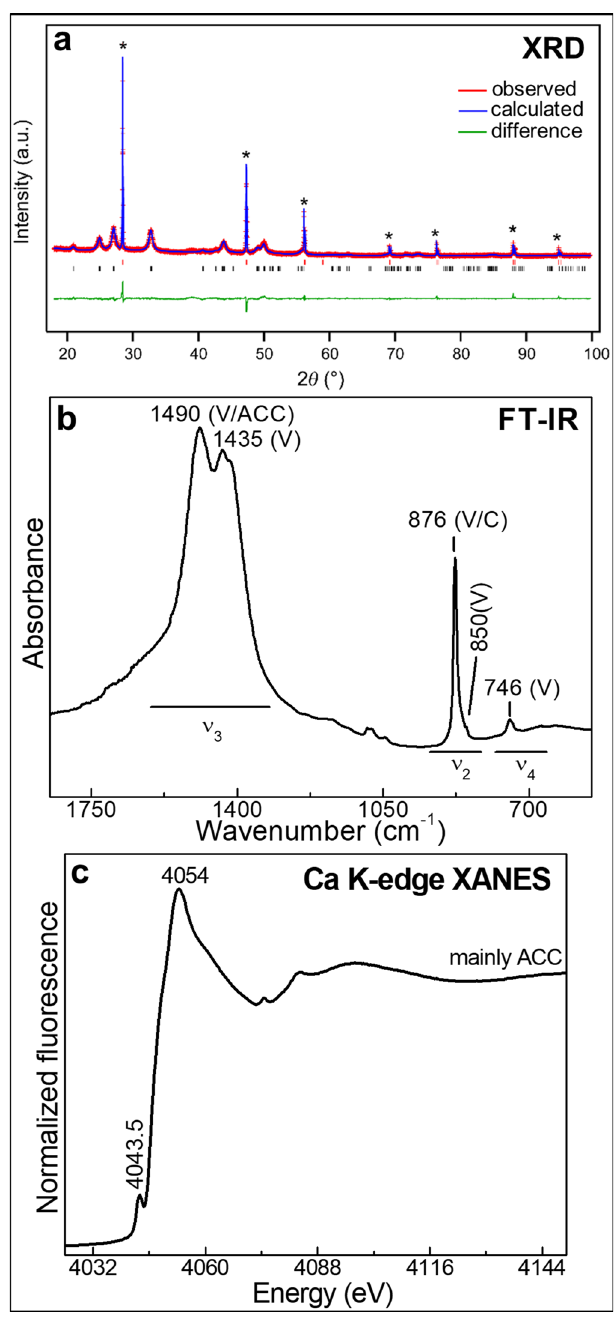
Figure 1. Bulk analysis of CFW consolidant after storing at RH = 50% (T = 40 °C, 5 months): (a) Rietveld refinement performed by GSAS 33 , (b) FT-IR and (c) Ca K-edge macro-XANES spectrum (unfocused beam, 200 µm pinhole) normalized by ATHENA 44 . In (a) , the peaks marked with an asterisk are related to the silicon added as internal standard. Red and black vertical bars at the bottom indicate the calculated positions of peaks for silicon and CFW consolidant, respectively. In (b) , letters denote: V = vaterite, ACC = amorphous calcium carbonate, C =